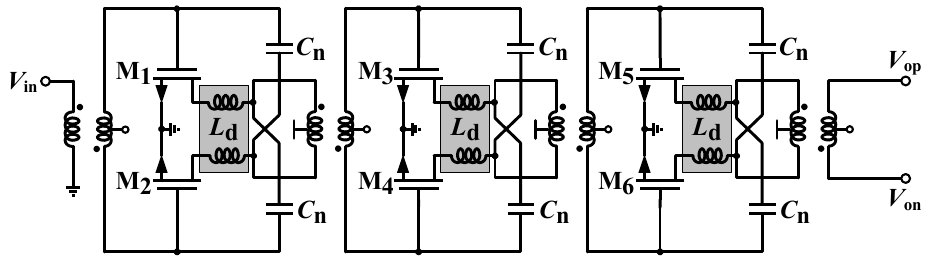
Figure 1. Schematic of the proposed low noise amplifier.